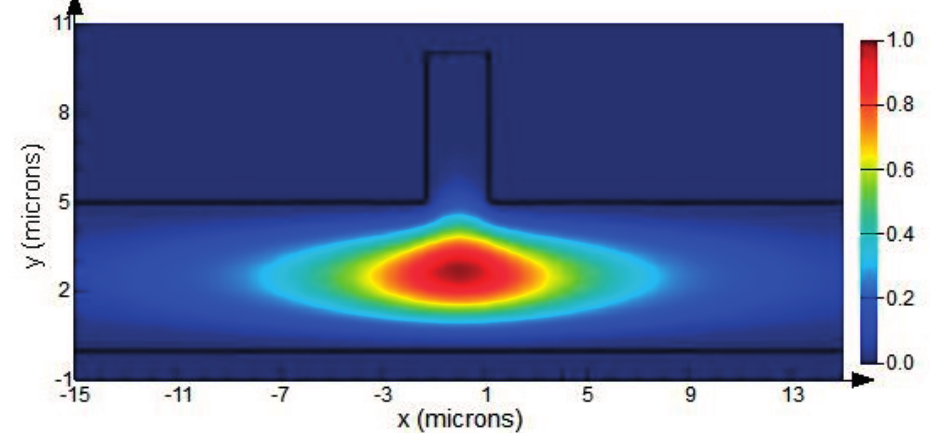
Figure 4. Simulation of the fundamental EH mode of the SOI rib waveguide with H = 10 μ m, h = 5 μ m, w = 2.5 μ m at wavelength of 1550 nm, calculating with full-vector finite difference method